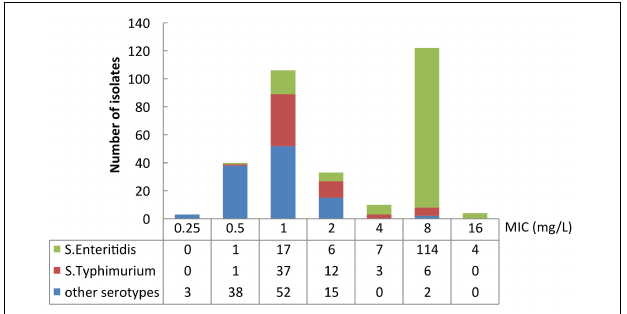
FIGURE 1 | Number of isolates and MIC distribution of different serotypes of Salmonella . “Other serotypes” presents serotypes except for Enteritidis and